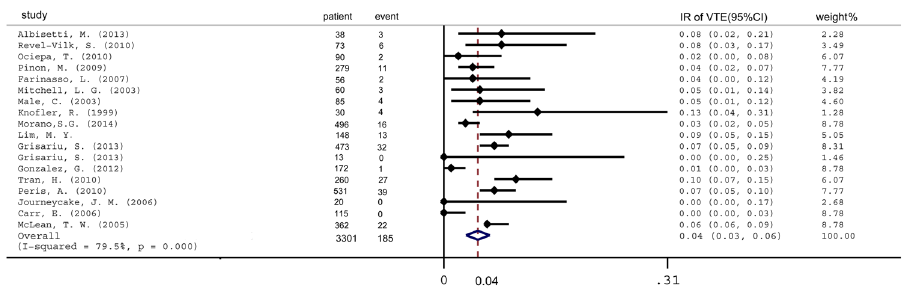
Figure 5. Pooled incidence of venous thromboembolism in patients with a catheter. IR = incidence rate. VTE = venous thromboembolism.